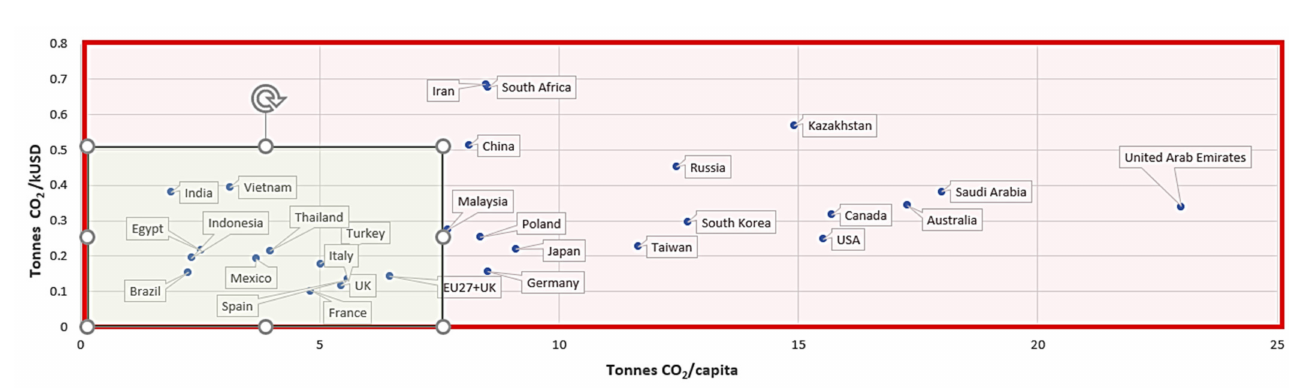
Figure 3. Traffic light diagram of the emissions per capita vs. emissions per kUSD. Own elaboration.